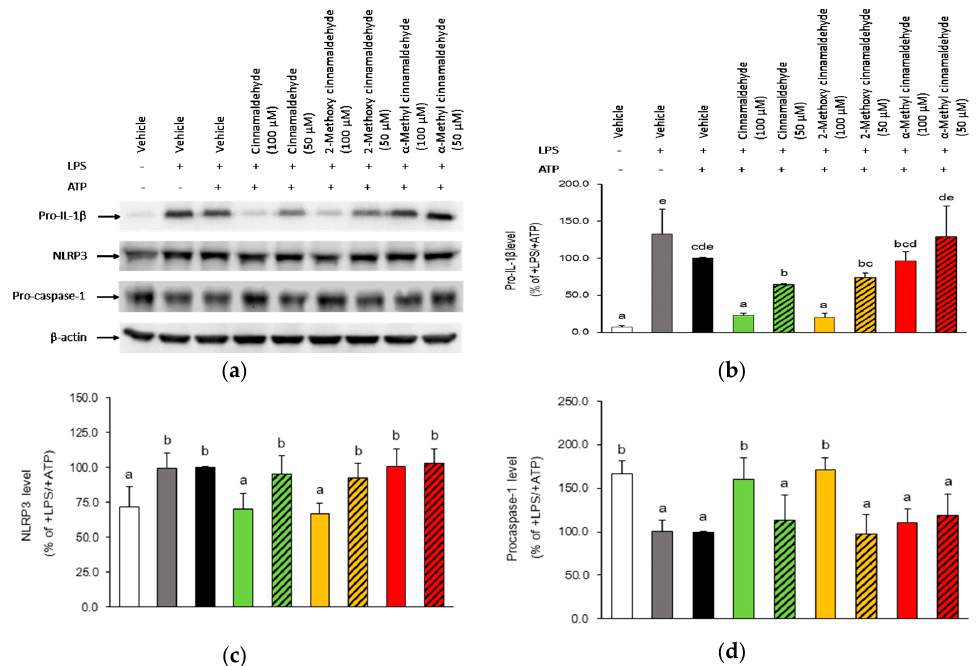
Figure 5. Influence of cinnamaldehyde-related compounds on the cytosolic pro-IL-1 β , NLRP3 and pro-caspase-1 levels in macrophages stimulated with LPS and ATP. The panels display a representative photogram of Western blot ( a ) and the quantified results of pro-IL-1 β ( b ), NLRP3 ( c ) and pro-caspase-1 ( d ), separately. The macrophages were pretreated with 100 μ M cinnamaldehyde-related compounds for 30 min and then treated with LPS and ATP. Cytosolic proteins were isolated and the pro-IL-1 β , NLRP3 and pro-caspase-1 amounts were further detected by Western blot. Data are expressed as the mean ± SD and different superscript letters represent statistically differences ( p < 0.05).